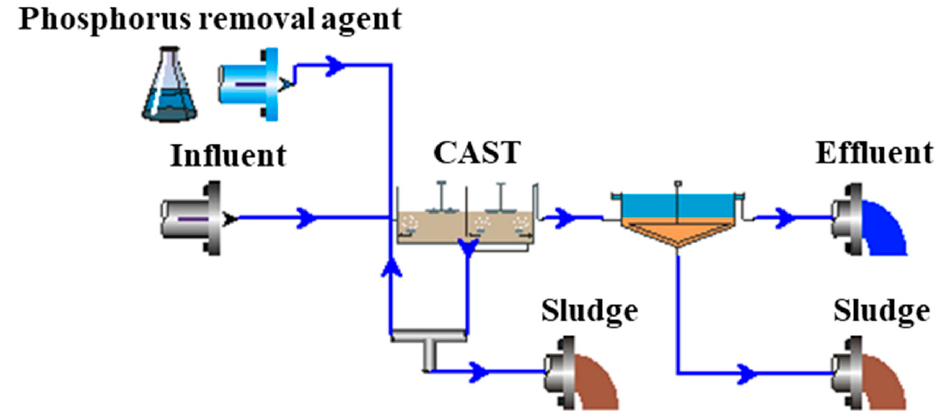
Figure 10. Generalized model of the CAST process based on BioWin.